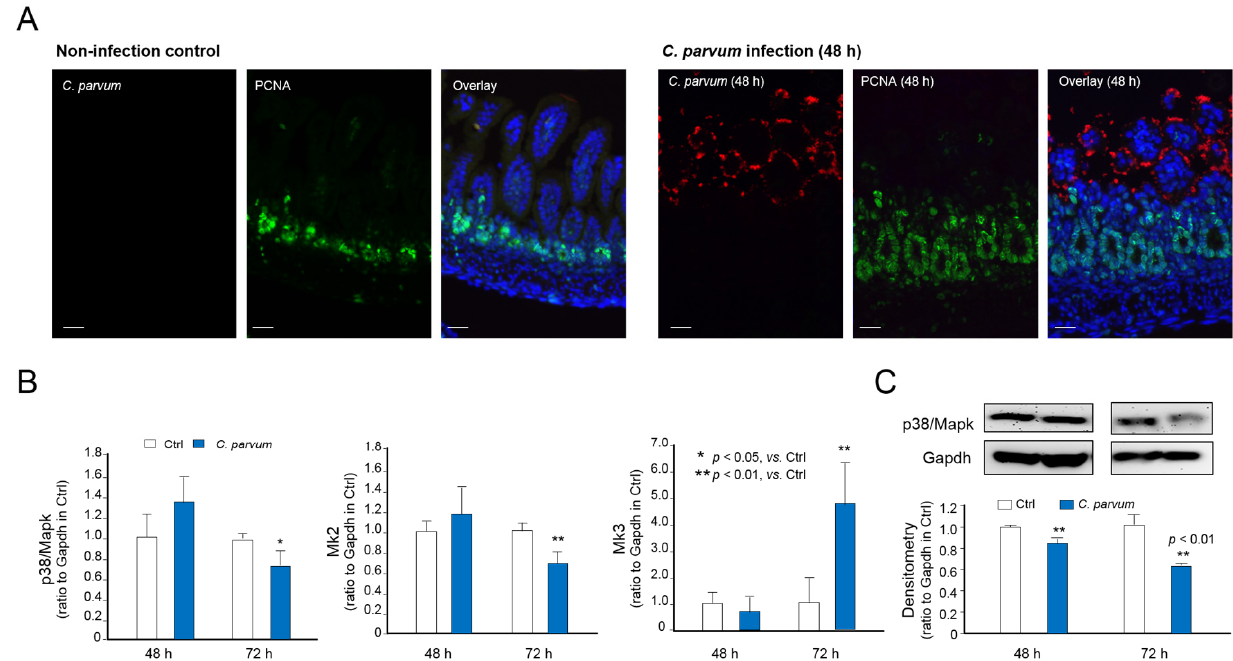
Figure 4. Downregulation of p38 / Mapk , Mk2 and Mk3 genes in intestinal epithelium of neonatal mice following C. parvum infection in vivo. ( A ) Immunofluorescent staining of ileum from neonatal mice with and with C. parvum infection. Mice at the age of 5 days after birth received C. parvum oocysts by oral gavage (10 5 oocysts each mouse). Mice which received phosphate buffered saline by oral gavage were used as control. Tissue sections were triple stained with anti- C. parvum (showing in red), anti-PCNA (showing proliferating cells in green) and DAPI (showing nuclei in blue). ( B ) RNA levels of p38 / Mapk , Mk2 and Mk3 genes in isolated intestinal epithelium from infected neonatal animals. RNA levels of p38 / Mapk , Mk2 and Mk3 genes were measured by using real-time PCR. ( C ) Protein level of p38/Mapk in isolated intestinal epithelium from infected neonatal animals. Protein level of p38/Mapk was assessed by using Western blot. Gapdh was also blotted for control. DAPI = 4 ′ ,6-diamidino-2-phenylindole; PCNA = Proliferating cell nuclear antigen.